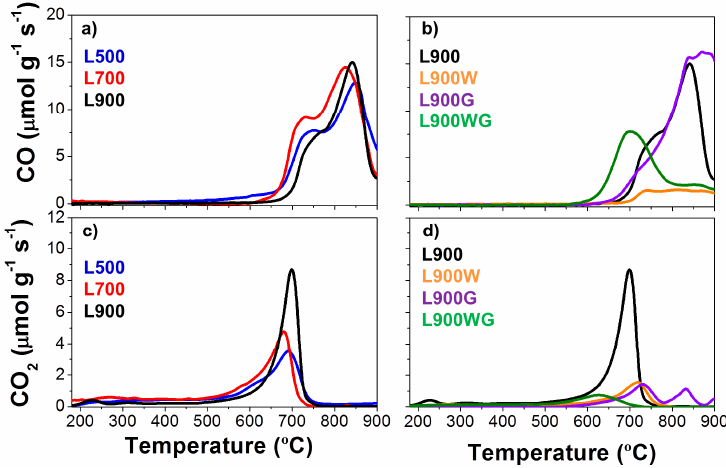
Figure 5. TPD profiles of the different carbon catalysts. ( a , b ) CO evolution; ( c , d ) CO 2 evolution of different carbon catalysts.